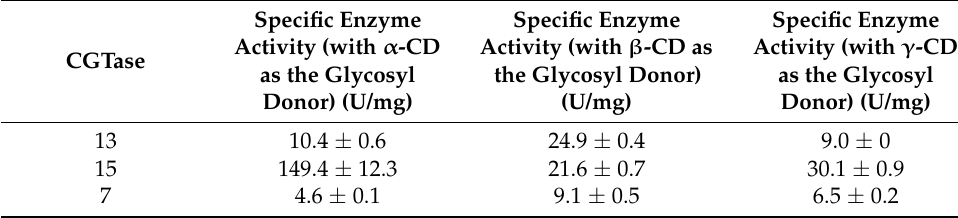
Table 4. Coupling activity of CGTases.